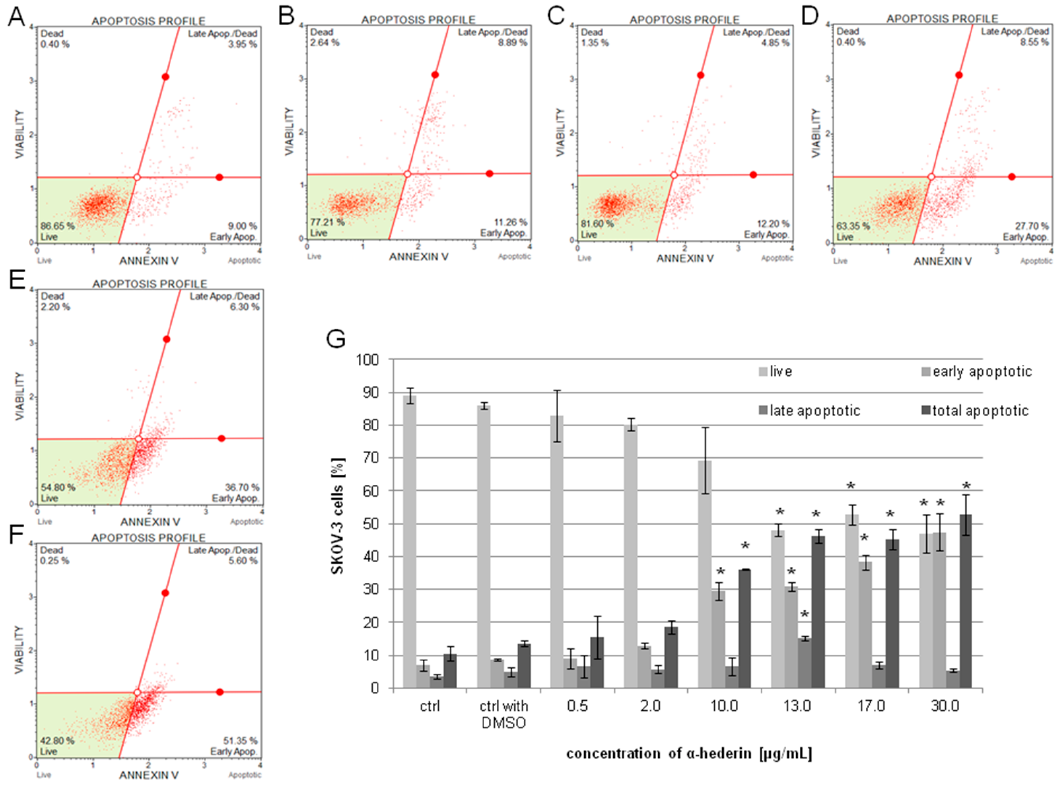
Figure 5. Apoptosis assay on SKOV-3 cells treated with α -HN. The SKOV-3 cells were examined by flow cytometry using annexin V / 7-AAD staining method. The percentage of apoptotic cells was estimated in the control sample of the untreated cells (control), after the cells’ incubation with DMSO (control with DMSO) at concentration of 0.5% ( A ) or with α -HN at concentrations of 0.5–30 µ g / mL for 24 h (particular concentrations are represented in pictures: 0.5 ( B ), 2 ( C ), 10 ( D ), 17 ( E ), and 30 µ g / mL ( F